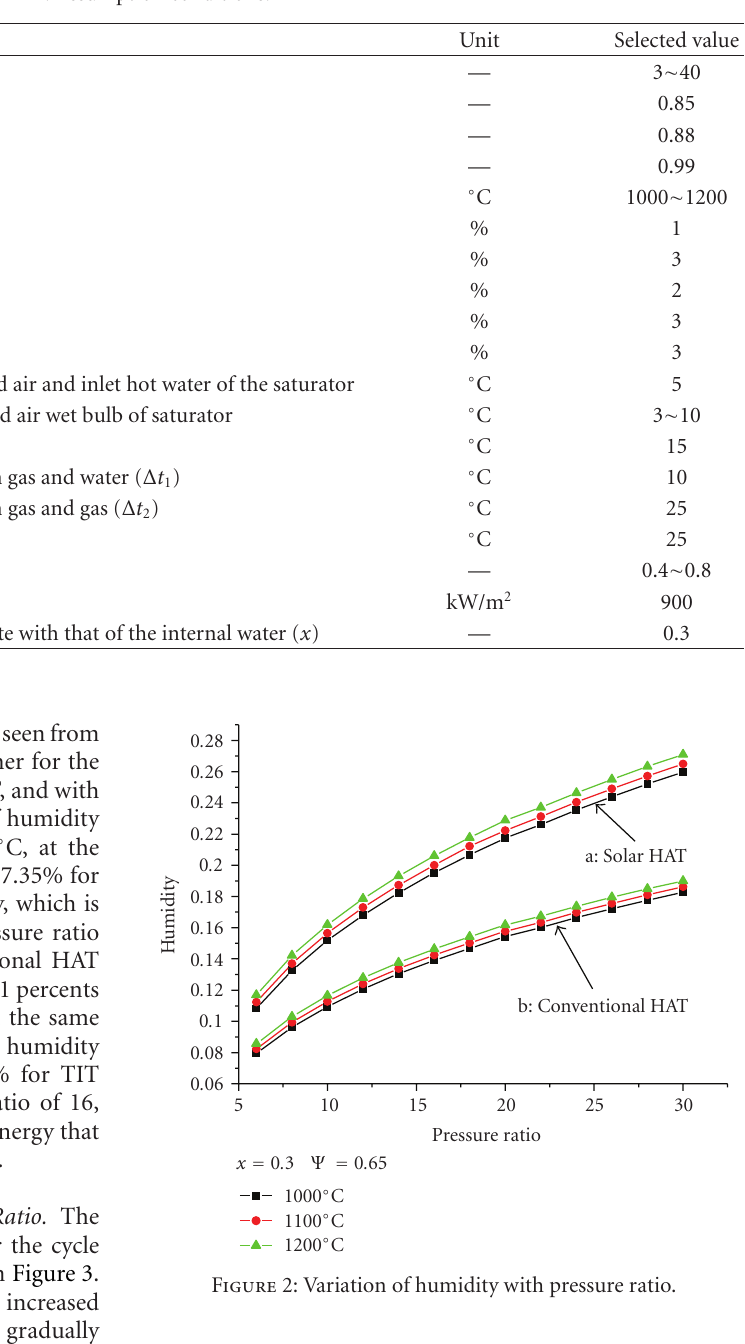
5.1.3. Exergy E ffi ciency. Figure 4 depicts the e ff ect of pressure ratio on exergy e ffi ciency of the cycle at di ff erent turbine inlet temperatures. At the lower solar collector e ffi